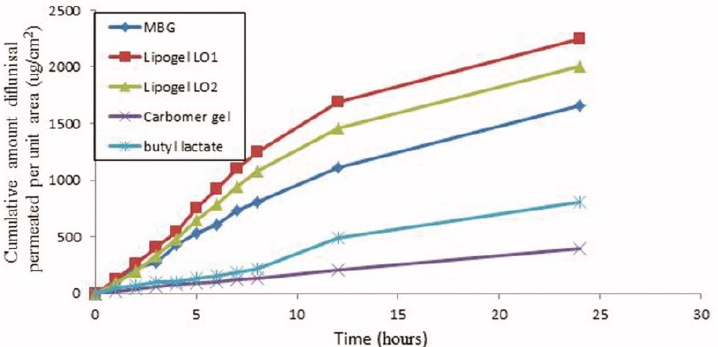
Figure 8. Human skin penetration profiles of diflunisal from microemulsion-based hydrogel, organogels (LO1 and LO2), carbomer gel, and butyl lactate into phosphate-buffered saline (PBS) (pH 7.4) at 32 °C. MBG—microemulsion-based hydrogel form; LO1—organogel based on Lipoid S75; LO2—organogel based on Phospholipoin 85 G. Reproduced from [36], with permission from Taylor & Francis, 2021.